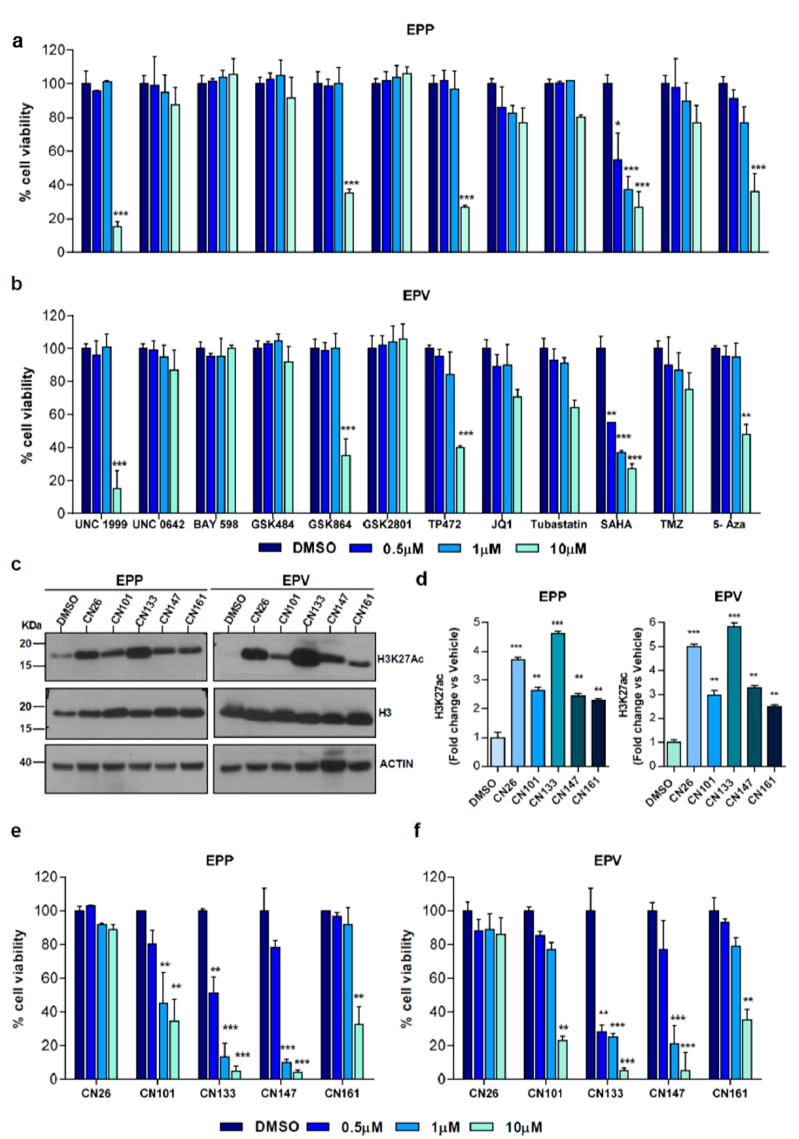
Figure 1. Epigenetic drug screening in patient-derived EPN cell lines: ( a ) EPP or EPV ( b ) cell lines were treated with either vehicle (DMSO) or the indicated drugs at 0.5 µM, 1 µM or 10 µM for 72 h. Cell viability was evaluated using Alamar Blue; ( c ) Western blot of histone acetylation levels upon treatment with the indicated compounds (1 µM) for 48 h in EPP and EPV cell lines. Uncropped Blots of Figure 1c are shown in Figure S9 ( d ) graph represents the quantification of ( c ); H3K27ac were normalized versus total H3 and expressed as a fold change versus DMSO-treated cells; five experimental brain-penetrating HDACis were tested in cell viability assays on EPP ( e ) and EPV ( f ). Each graph represents the average of three independent experiments ( n = 6/each experiment) ± SEM ** p < 0.01; *** p < 0.001.